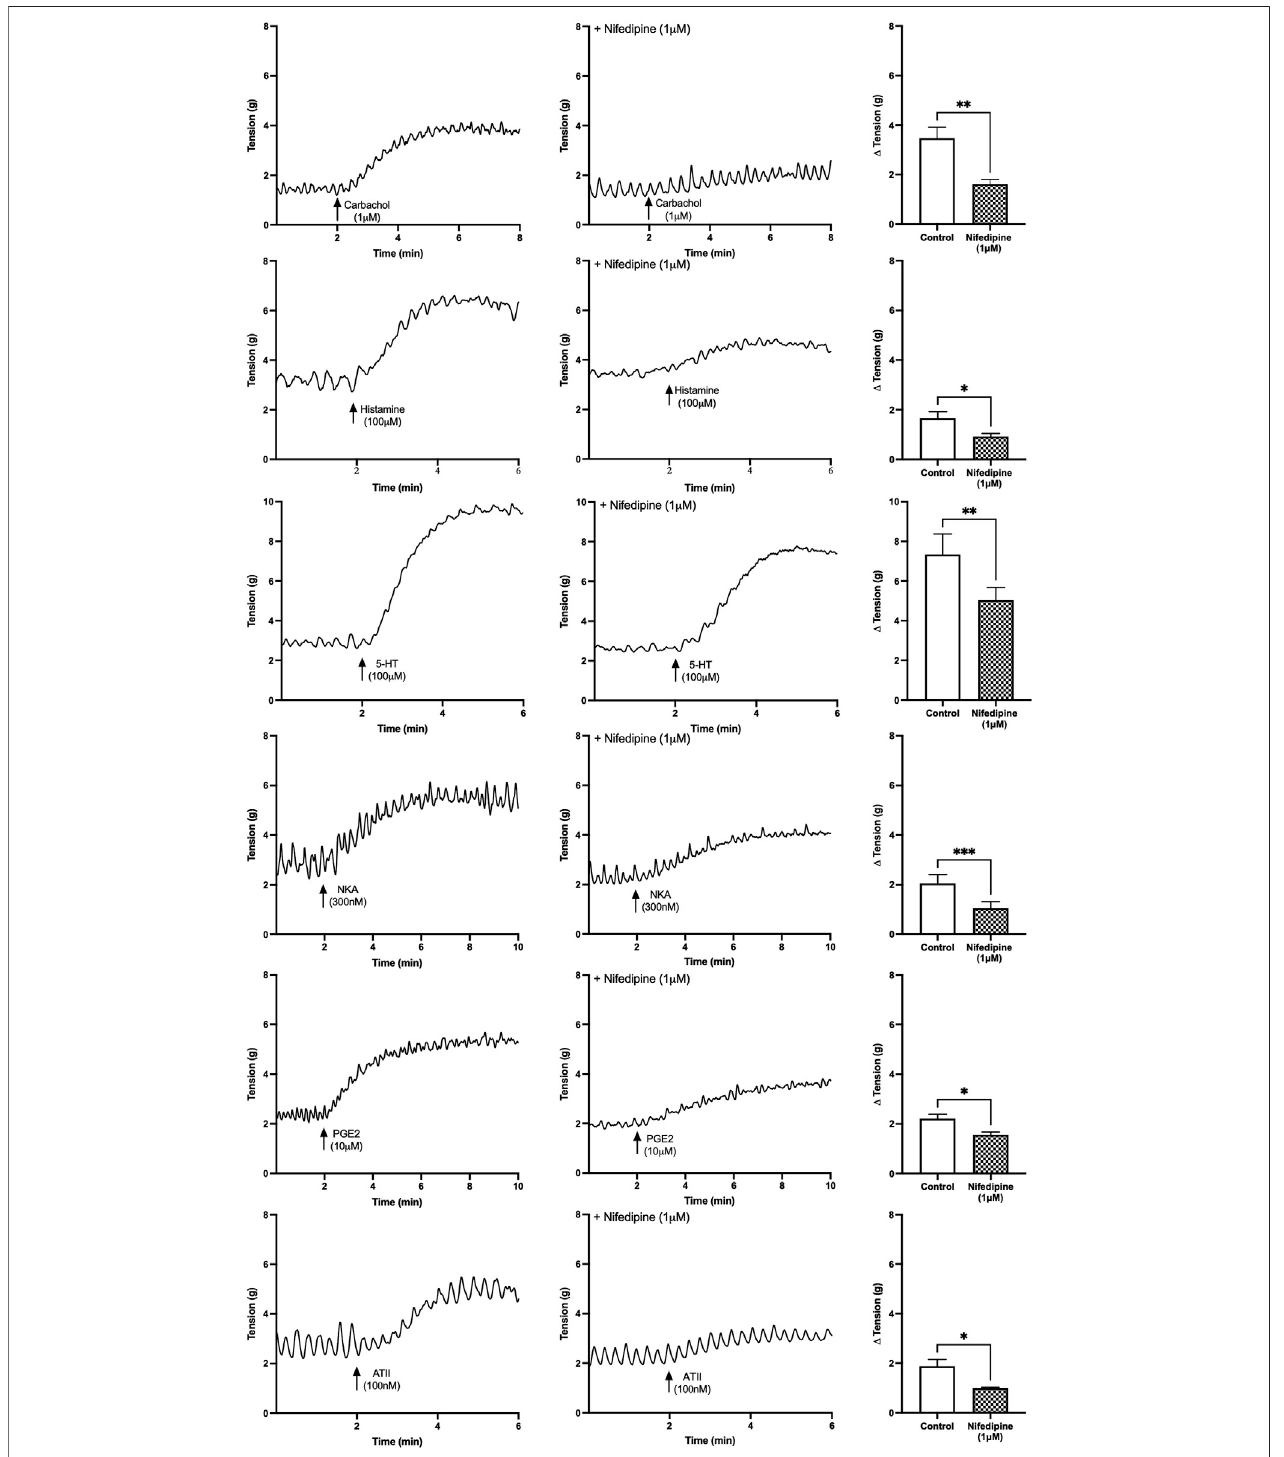
FIGURE 1 | U&LP baseline tension responses to receptor agonists carbachol (1 µM), histamine (100 µM), 5-HT (100 µM), NKA (300 nM), PGE2 (10 µM), and ATII (100 nM) in the absence of (left) and the presence of (right) nifedipine (1 µM). * p < 0.05, ** p < 0.01, *** p < 0.001 (paired Student ’ s two-tailed t -test).